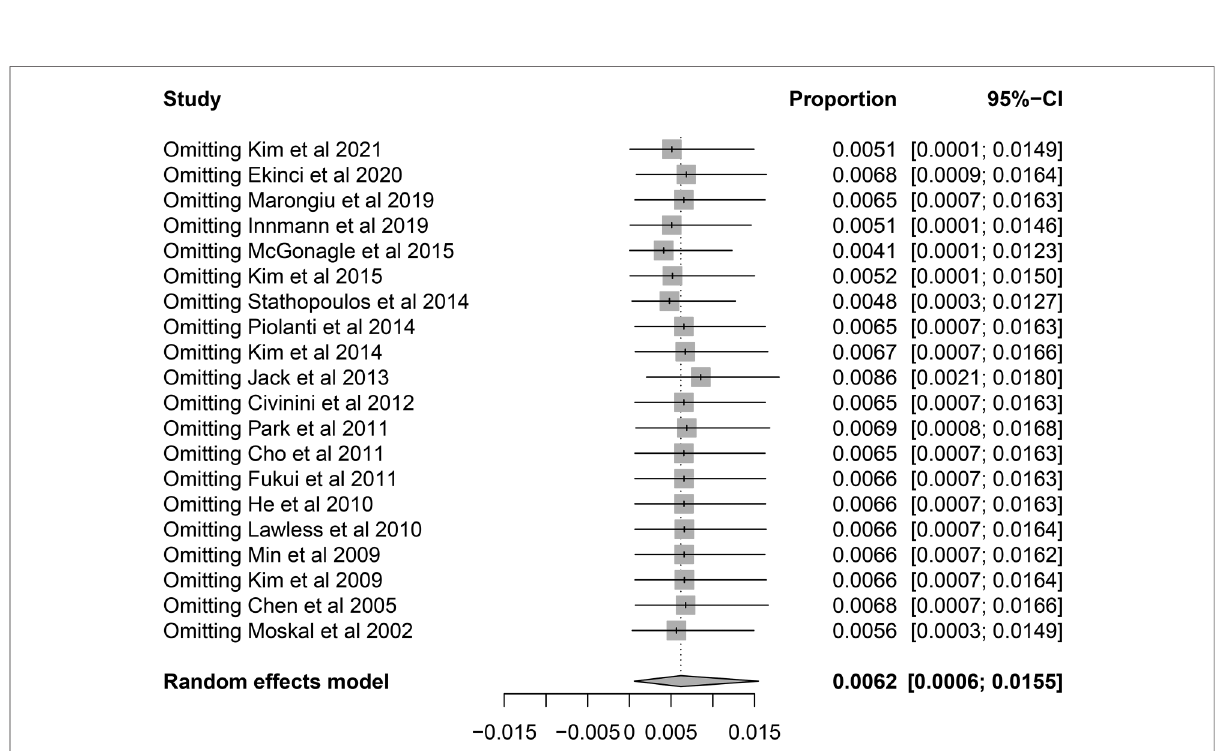
FIGURE 8 Sensitivity analysis for the re-revision rate of retained stems for aseptic loosening using leave-one-out